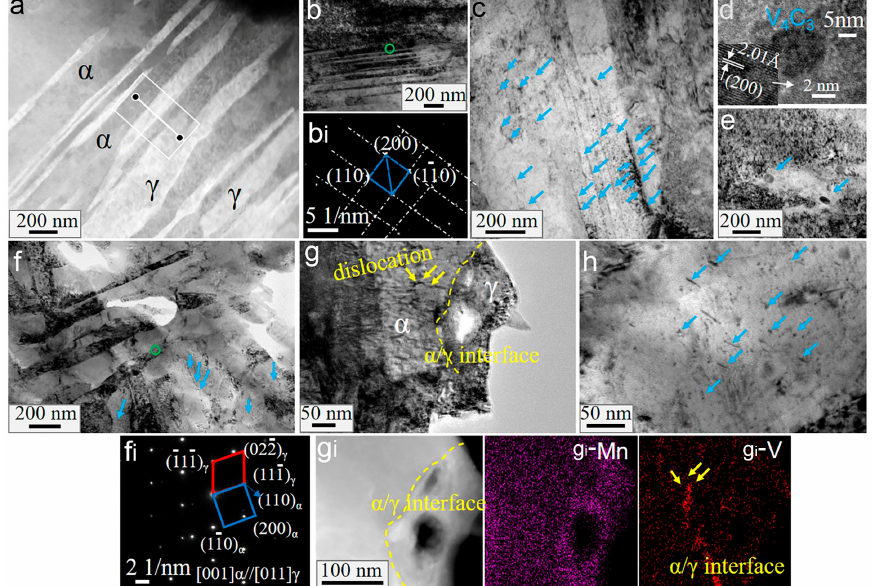
Figure 7. TEM micrographs of HV600 ( a – e ) and HV700 ( f – h ): ( a ) EDXS line profile analysis; ( b ) ul- trafine ferrites; ( c ) carbides around the interfaces; ( b i ) the selected area diffraction (SADP) in the green circle in ( b ); ( d ) high-resolution TEM (HRTEM) images of carbide; ( e ) dislocations and carbides intertwining; ( f , g ) the bright field images; ( f i ) and ( g i ) SADP of ( f ) and EDXS surface analysis of ( g ); g i -Mn and g i -V refer to the distribution of Mn and V elements after surface analysis of g i , respectively; ( h ) distribution of carbides. The blue arrows refer to the carbide, the yellow arrows refer to dislocation, and the yellow dashed line refers to the phase interface in the